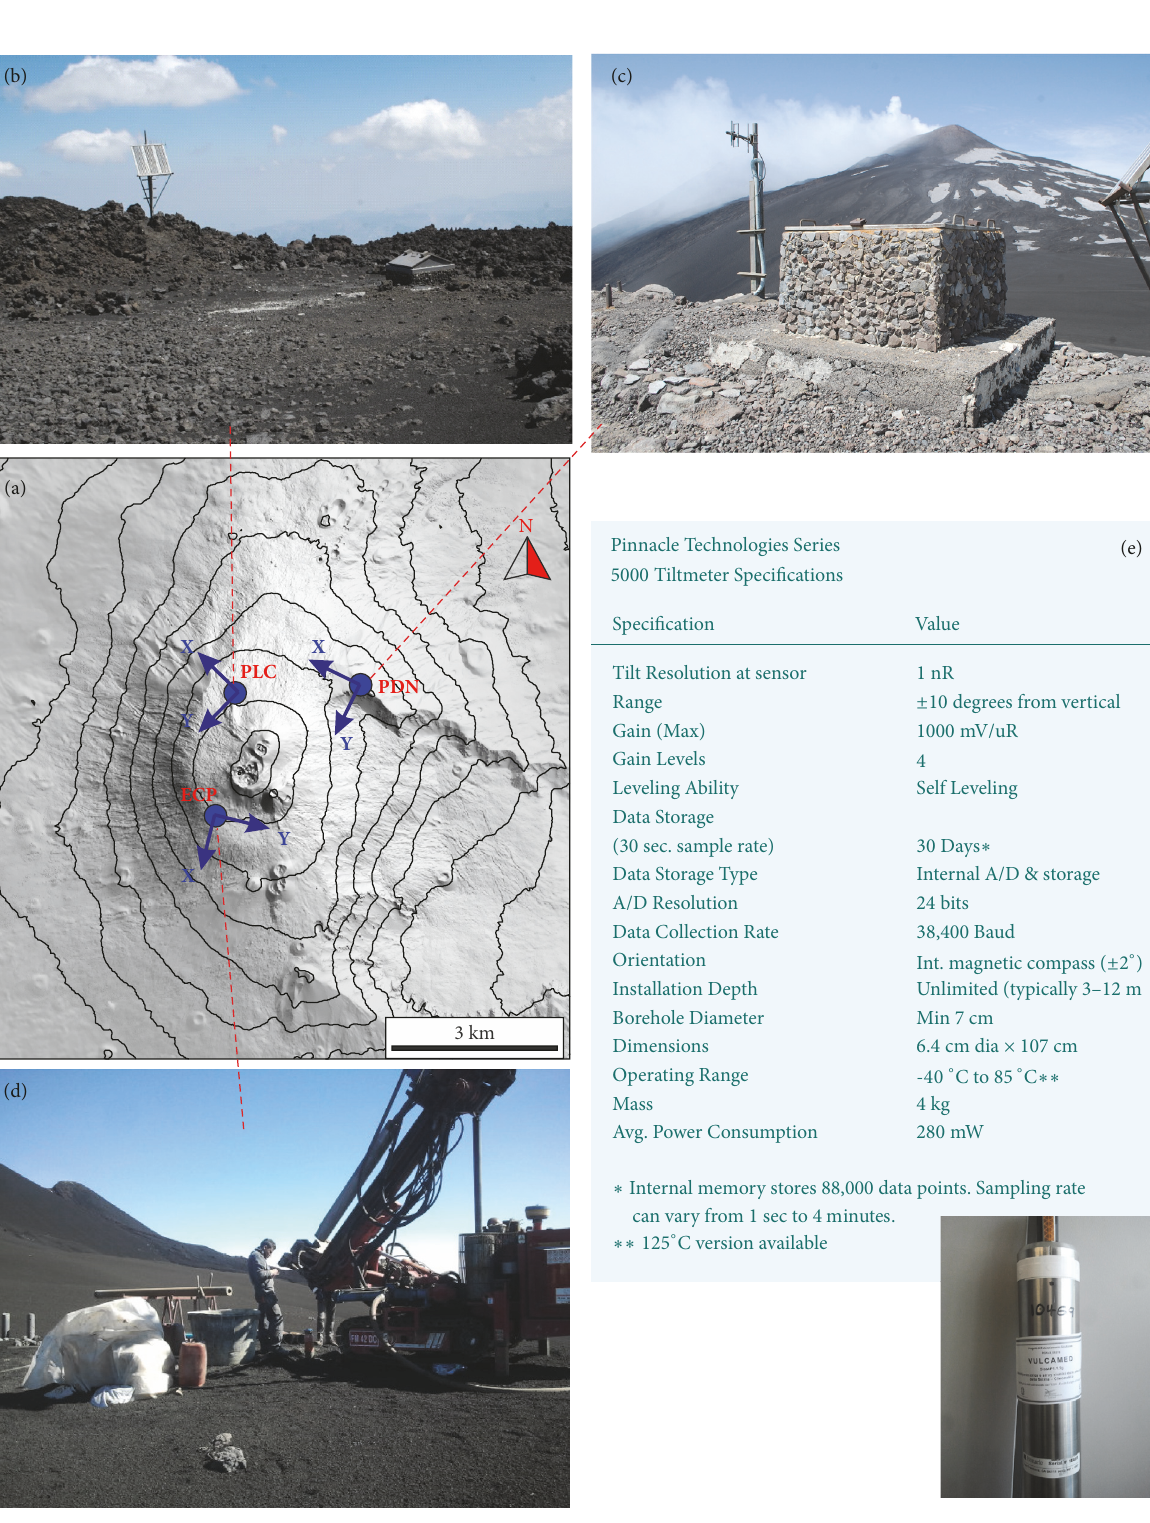
Figure2: Mapof thethreesummittilt stationswithaxis direction (a)and photosrelated toinstallation phases (b,c, d). (e)reportsthePinnacle Series 5000 tiltmeter